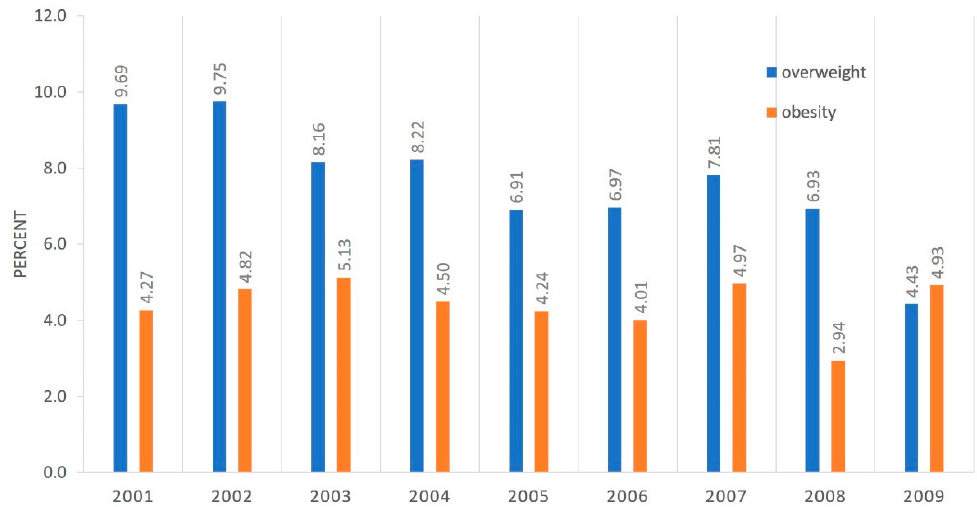
Figure 2. Prevalence of overweight and obesity at age 6-7 in girls by birth year.